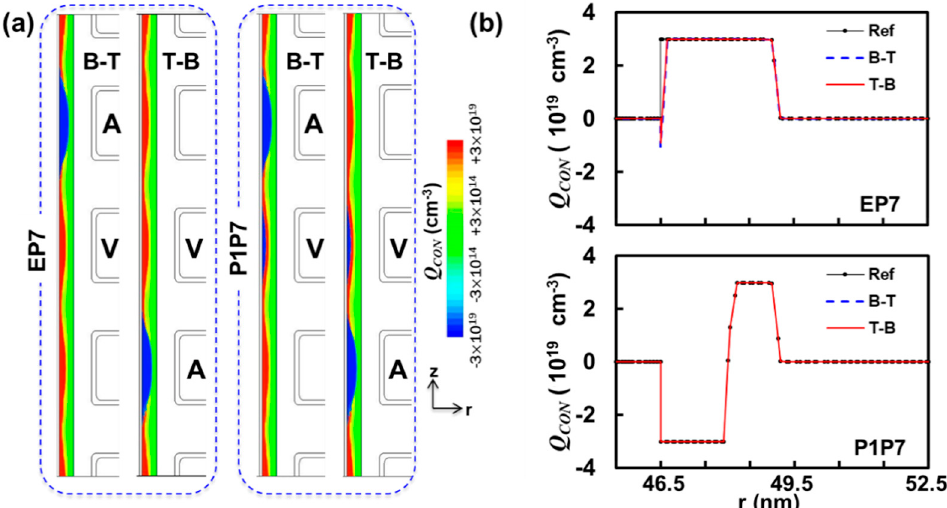
Figure 2. ( a ) Net charge concentration ( Q CON ) comparison of B-T and T-B. ( b ) Q CON in the trap-nitride layer of WL3 as a function radial coordinate r, where 46.5 nm and 52.5 nm represent two interfaces with oxide layers: top, EP7, where WL3 is originally at the state with V t = − 3.889 V (E). Slight change in Q CON for 46.5 < r (nm) < 46.7 is observed after interference, because of pass disturb (8 V); bottom, P1P7, where WL3 is initially at the state with V t = − 0.976 V (P1). In this case, pass disturb is negligible because P1 state is relatively invulnerable to V PASS = 8 V.